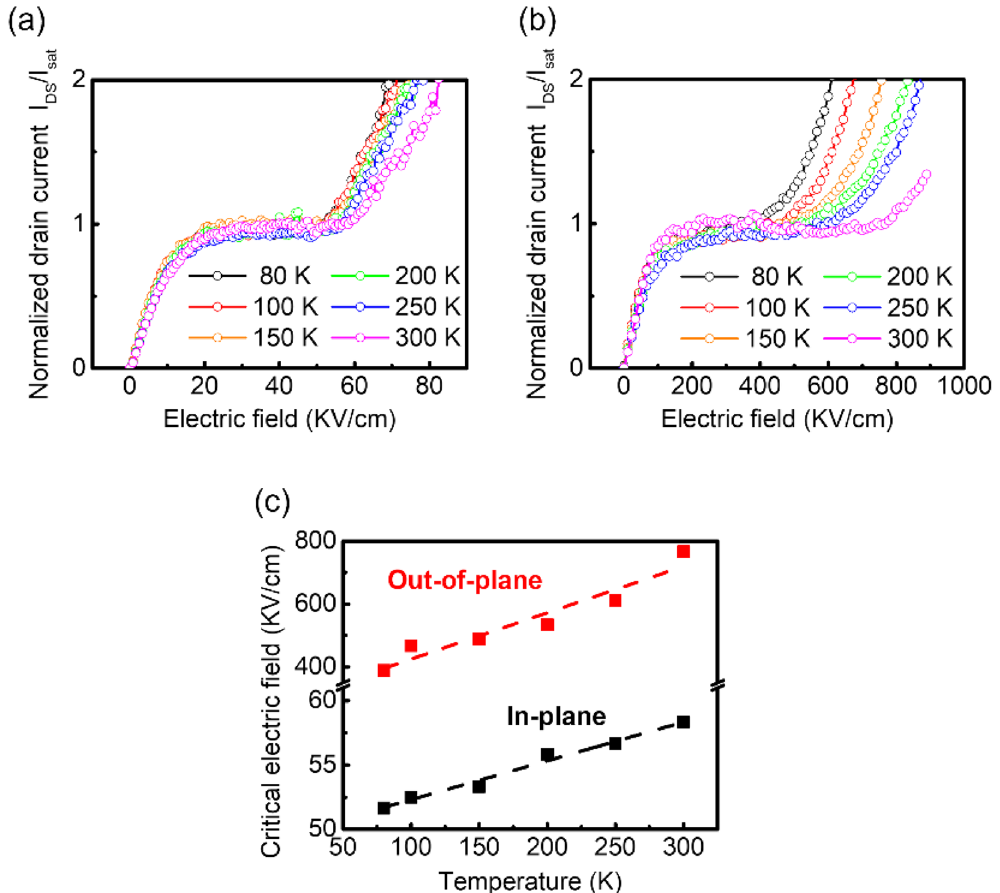
Fig. 4 Temperature-dependent impact ionization for in-plane and out-of-plane transport. Drain current normalized by the saturation current for a in-plane transport and b out-of-plane transport at various temperature ranging from 80 to 300 K. c Critical electric fields of in-plane (black square) and out-of-plane (red square) transport as a function of the temperature. The critical electric field decreases with decreasing temperature; the decrease is very slight for in-plane transport. Conversely, for out-of-plane transport, the decrease in the critical electric field due to the temperature drop is relatively large because optical phonon scattering is dominant in this transport